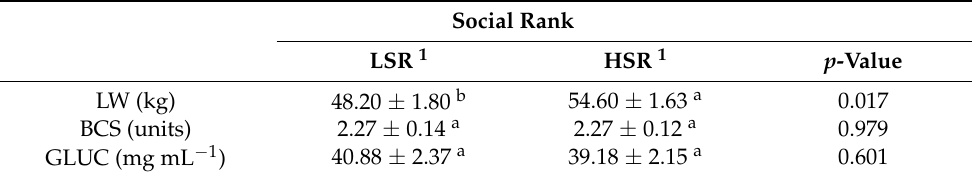
Table 1. Least-square means ± standard error for live weight (LW, kg), body condition score (BCS, units), and serum glucose concentration (GLUC, mg mL − 1 ) according to either low or high social rank (i.e., LSR and HSR) in crossbred (Alpine–Saanen–Nubian × Criollo; n = 15) dairy goats in northern Mexico (25 ◦ N) 1,2 . Social Rank LSR 1 HSR 1 p -Value LW (kg) 48.20 ± 1.80 b 54.60 ± 1.63 a 0.017 BCS (units) 2.27 ± 0.14 a 2.27 ± 0.12 a 0.979 GLUC (mg mL − 1 ) 40.88 ± 2.37 a 39.18 ± 2.15 a 0.601